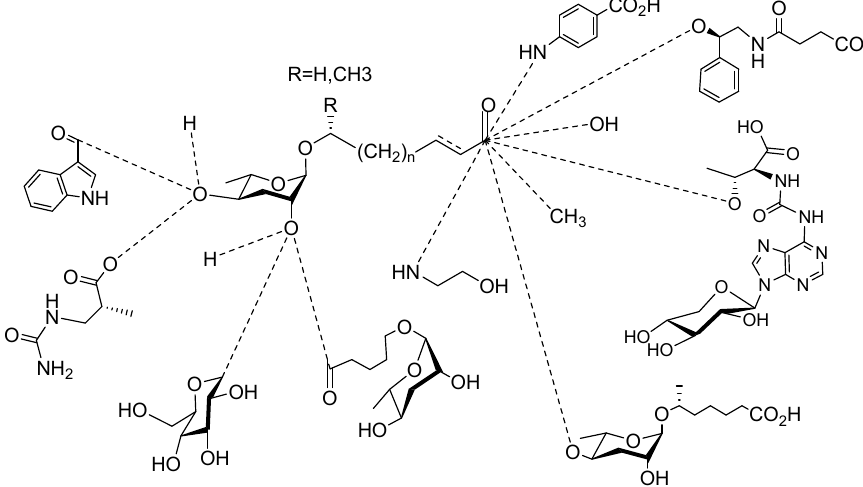
Figure 1. Overview of the chemical structure of development-related pheromones secreted by nematodes. Nacq#1 does not have an ascaroside structure, so it is not shown here, and its detailed structure is shown in Table 1.